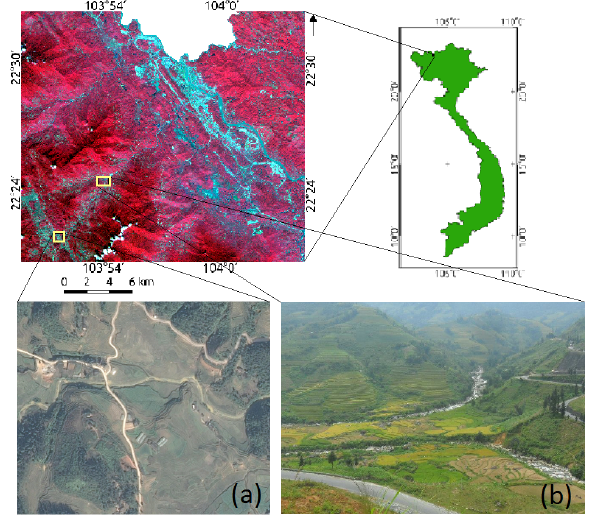
Figure 1. (a) a wide (Fa) and (b) a small (Fb) terrace field in Lao Cai area